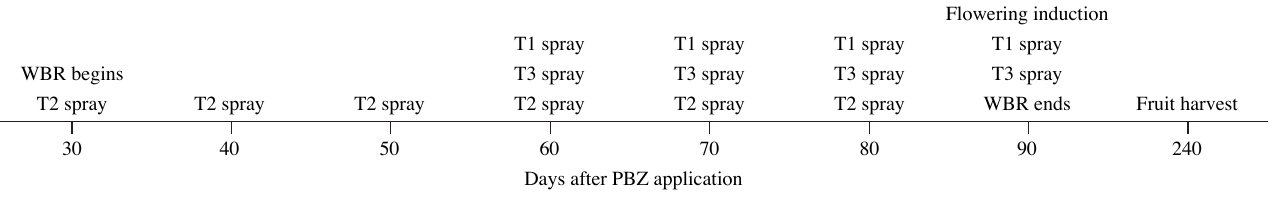
Fig. 1: Time scale of the main events during the